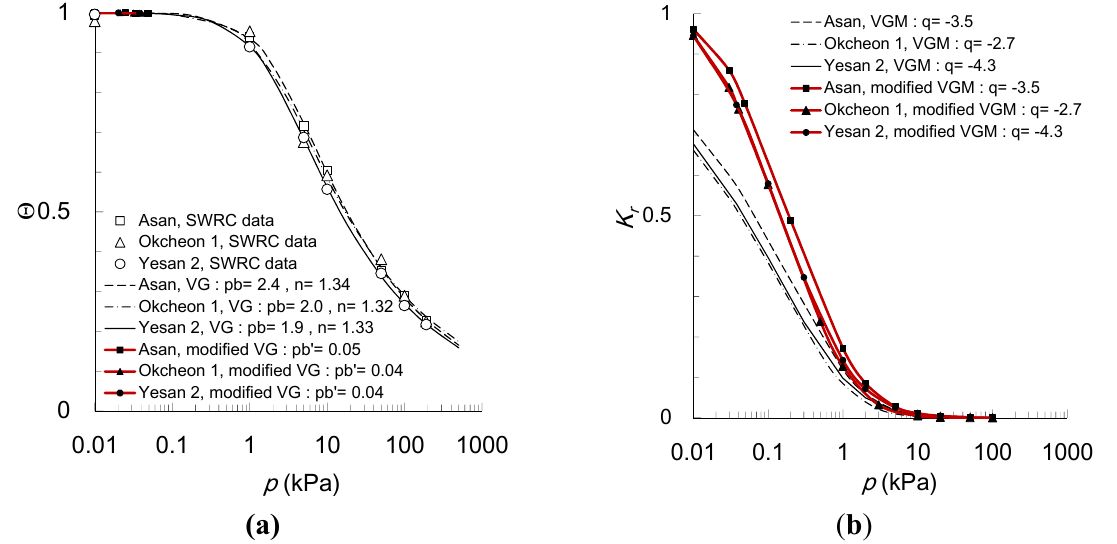
Figure 6. Comparison of the VGM model with the modified model in Group A-2: ( a ) soil water retention curves (The measured data are shown by points, and the modified VG curve by lines with point when p < p b ʹ ); ( b ) hydraulic